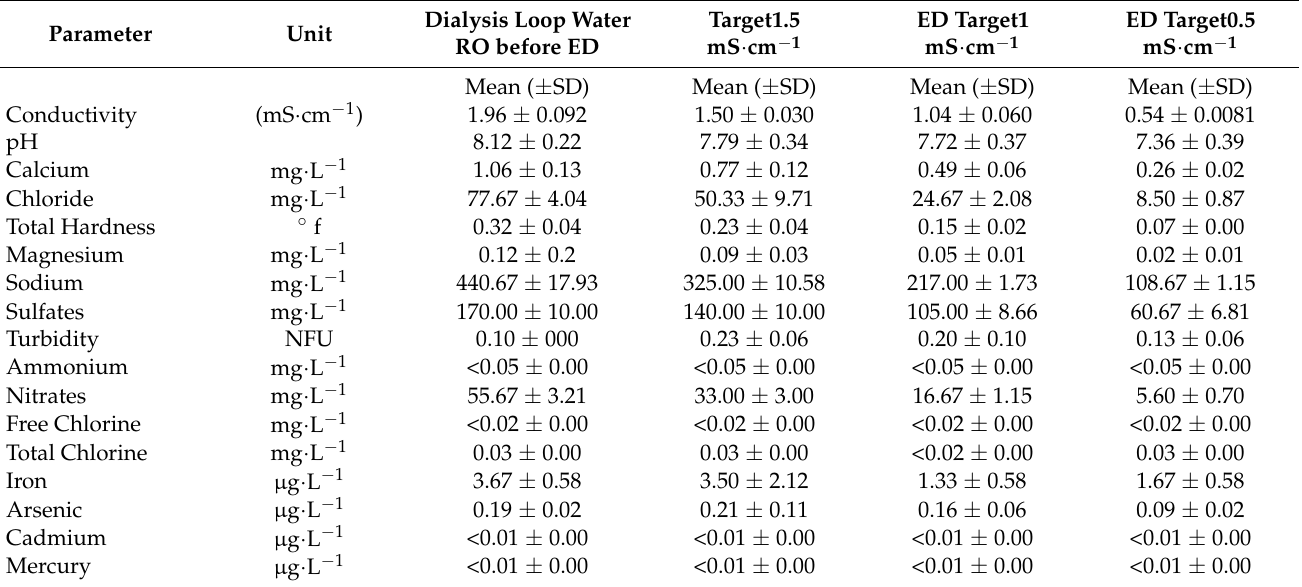
Table 3. Physico-chemical characterization of dialysis RO concentrates to reach conductivity targets: 1.5, 1.0, and 0.5 mS · cm − 1 ,